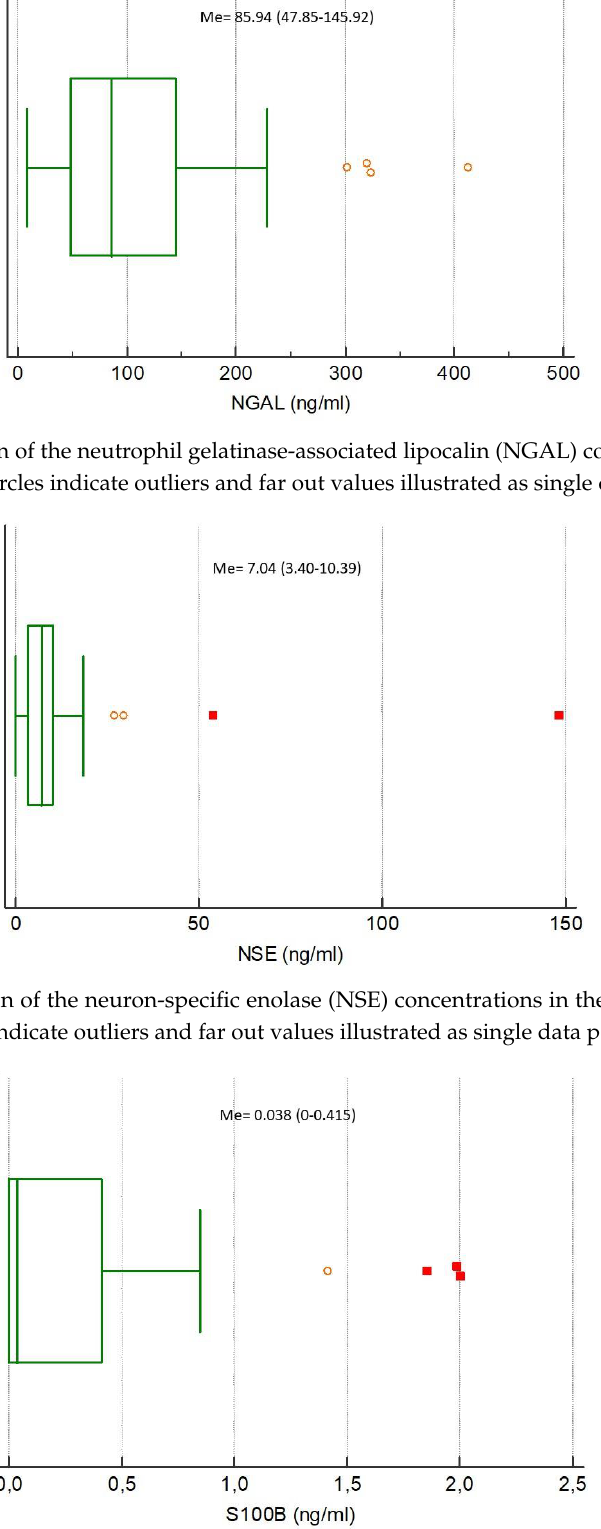
Figure 5. Distribution of the matrix metalloproteinase 9 (MMP-9) concentrations in the study population . Squares indicate outliers and far out values illustrated as single data points.